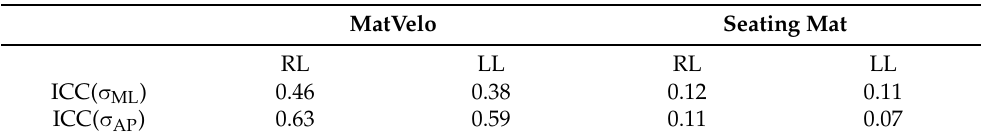
Table 3. ICC of our PSM and the commercial PSM compared with the PS-2141, where ICC( σ ML ) and ICC( σ AP ) are the intraclass correlation coefficients of the standard deviation of the ML and AP components, respectively. RL, right-leg trial; LL, left-leg trial. MatVelo Seating Mat RL